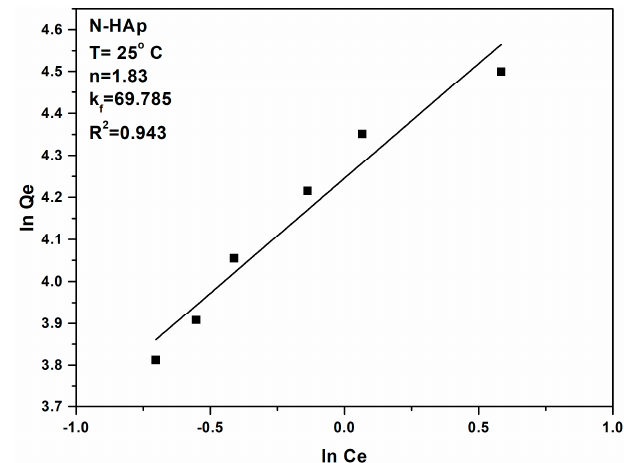
Figure 7. Freundlich linearized fits for the adsorption of lead ions on N-Hap.